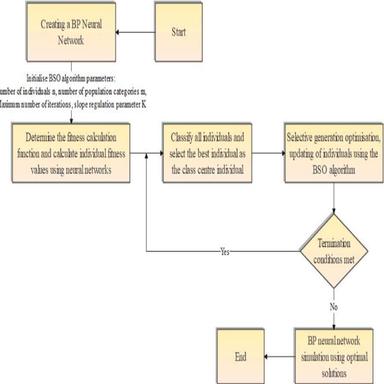
Flow chart of brainstorming optimization neural network algorithm.